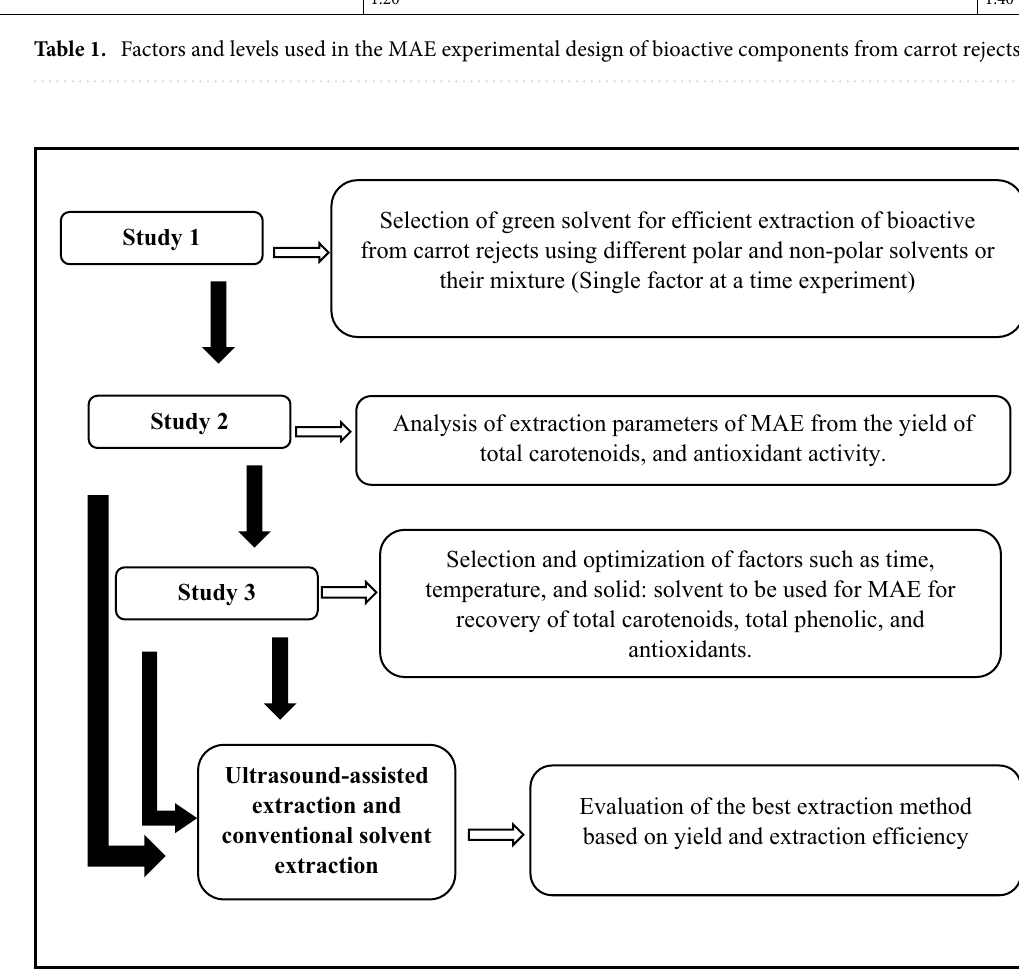
Figure 1. Experimental study plan of MAE of bioactive components from carrot